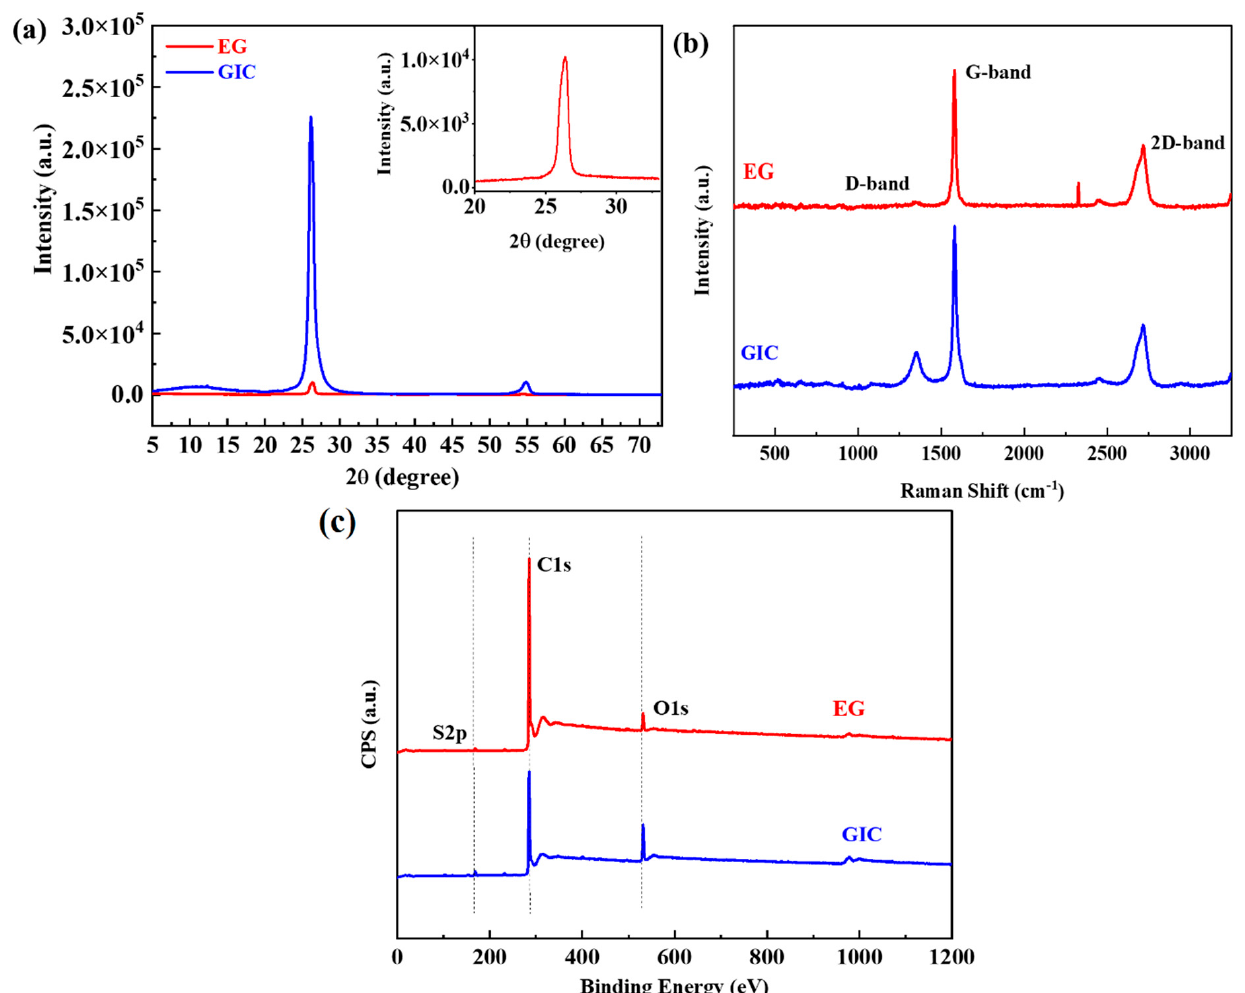
Figure 7. XRD spectra ( a ), RAMAN spectra ( b ), and XPS spectra ( c ) of GIC and EG filler .